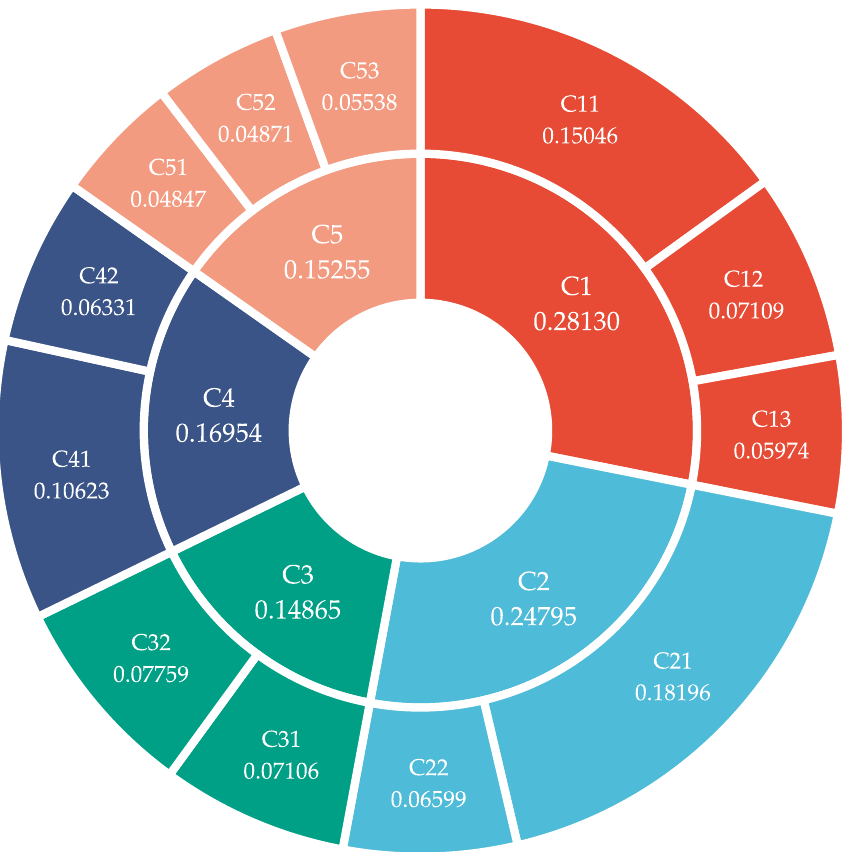
Figure 6. Weight calculation results.